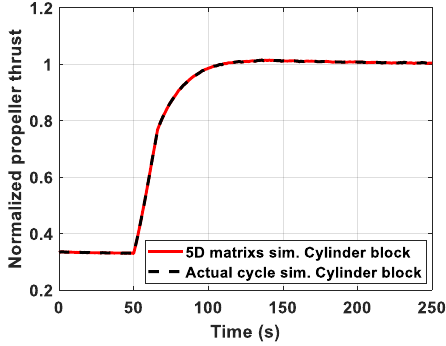
Figure 16. Propeller thrust time history.